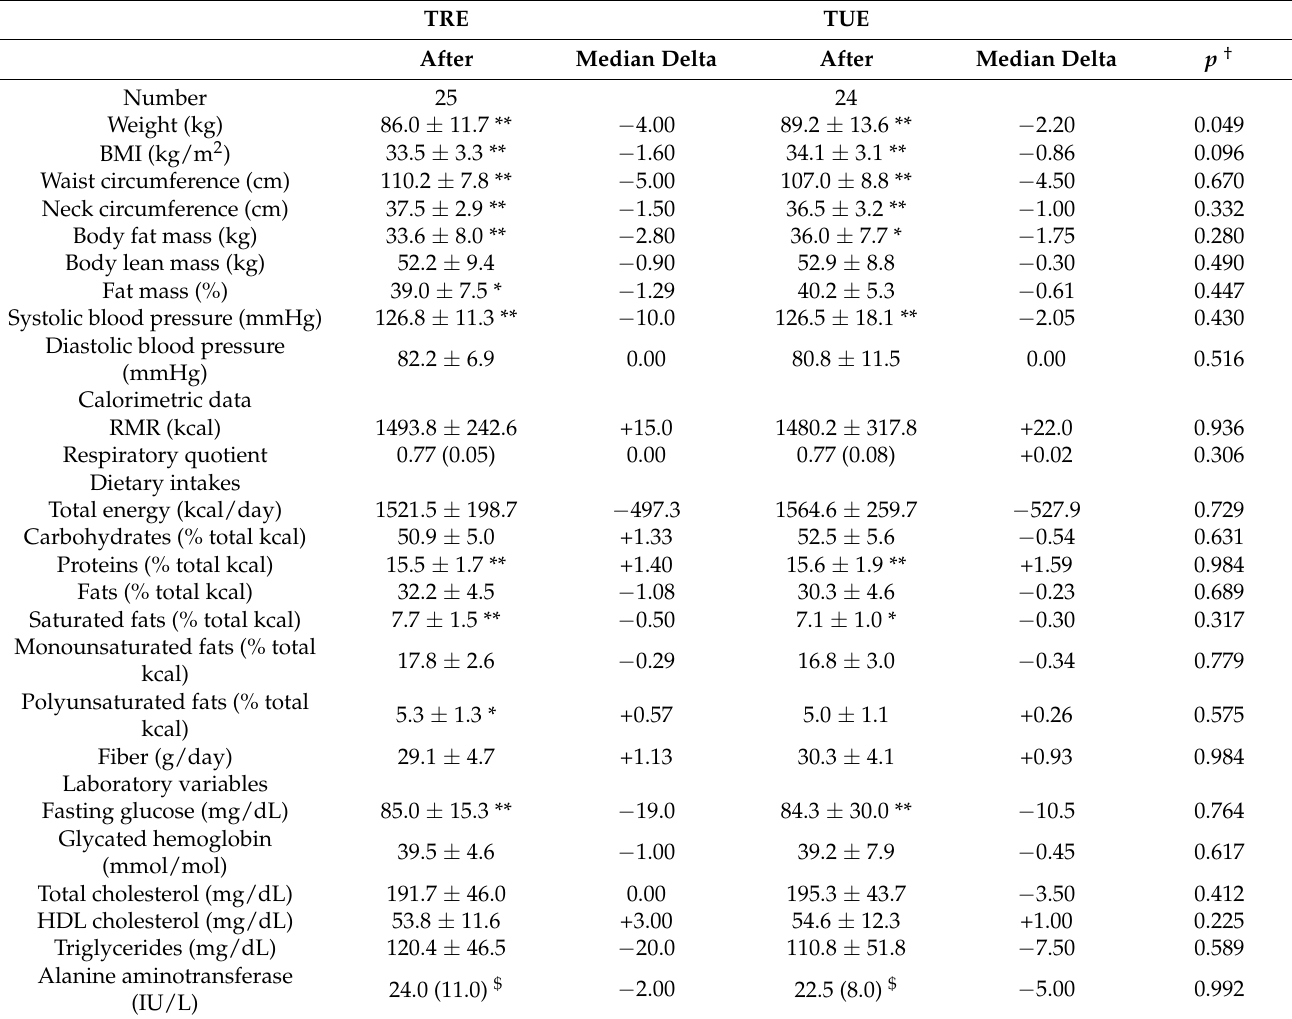
Table 2. Changes in the variables at 12 weeks by dietary